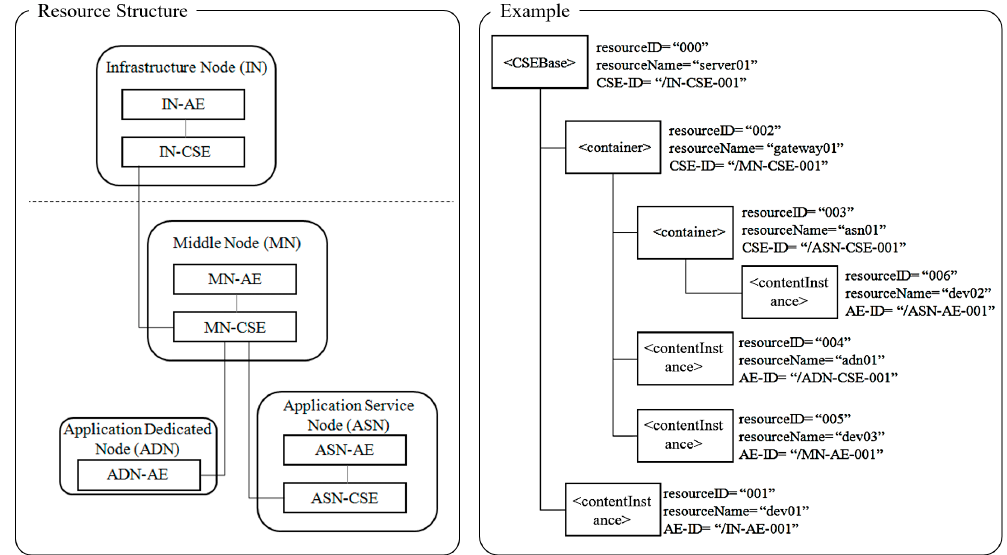
Figure 4. oneM2M resource structure.